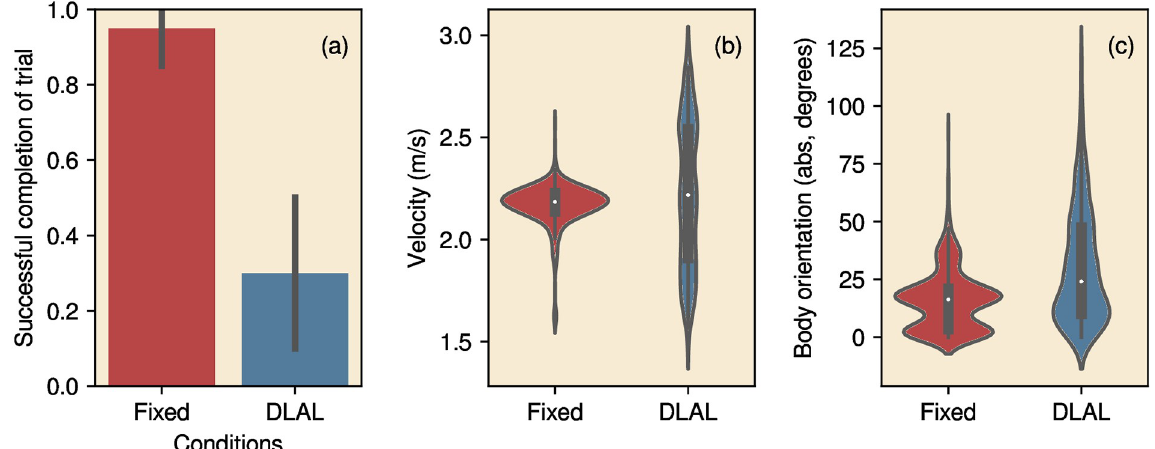
Fig 8. Performance of the robot in the corridor environment. (a) Proportion of trials in which the robot successfully reached the end of the corridor for the Fixed Head Strategy and DLAL Strategy. Lines indicate the 95% confidence intervals. (b, c) violin plots of the velocity and the body orientation for both strategies with respect to the corridor (0˚ is aligned with the